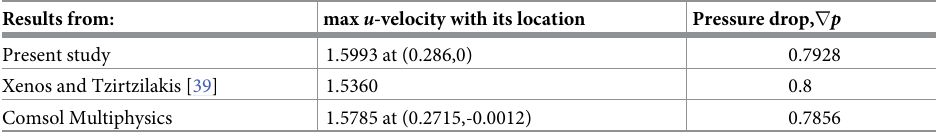
Table 1. Results for maximum u -velocity with its location and pressure drop, r p . Results